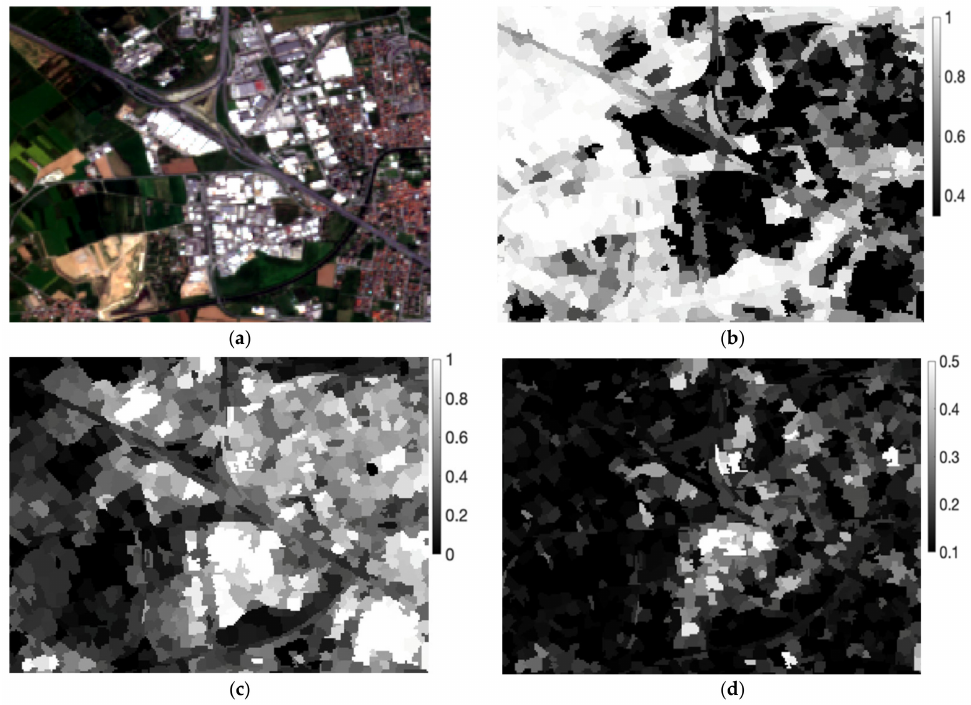
Figure 8. SAR features example, using the segmentation scheme. ( a ) S2 reference image ( b ) Differen- tial entropy ( c ) Sigma naught ( d ) Polarimetric